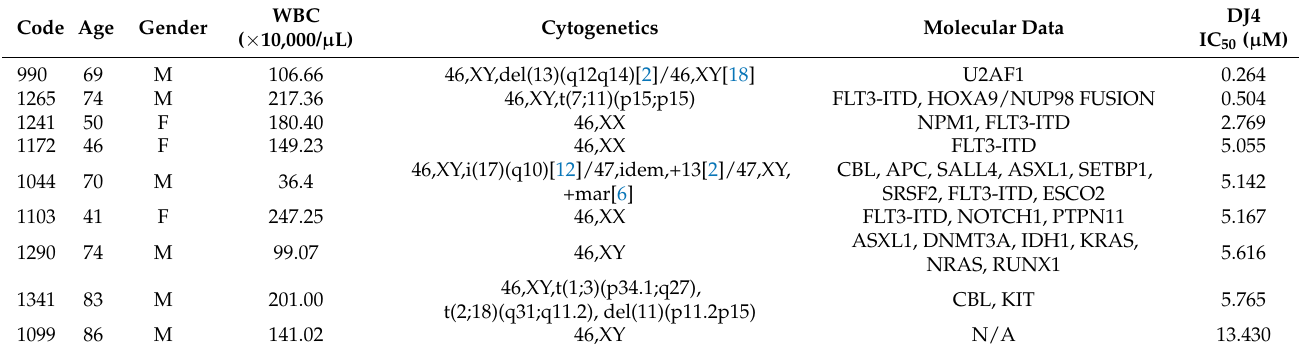
Figure 2. DJ4 reduces clonogenicity in AML patient samples while sparing healthy donor cells. ( A ) Clonogenicity of the primary AML samples relative to the cord blood mononuclear cells (CB-MNCs) in the presence of DJ4. The data were analyzed via two-way ANOVA (Dunnett’s multiple comparisons test) to compare the grand mean colonies, shown with a blue line, of DJ4 treatment versus the control colonies, wherein **** p < 0.0001 was considered significant. ( B ) Representative microscopic images (4 × ) illustrating the number of colonies with increasing DJ4 concentrations in AML primary patient sample 1241 versus the control CB-MNCs. ( C ) Extrapolation of the IC 50 ( µ M) values from the colony-forming assay in ( A ). The results were assessed by means of the unpaired t -test and *** p < 0.001 was considered significant. The data are the means ± SEM. Table 1. AML patient information and the corresponding IC 50 ( µ M) values for